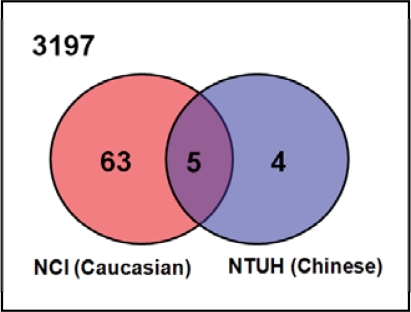
The Venn diagram of significant genes in our and NCI datasets. In order to compare the difference of differentially expressed genes selected in NTUH and NCI datasets, we only focus on the gene probes common in both datasets. After filtering out the genes only present in either NTUH or NCI datasets, a total number of 3197 genes were left, and were considered as our common candidate gene pool for further identification. In the NCI dataset, 68 of the 88 differentially expressed genes (refer to Fig. 1) were in the pool; while NTUH dataset has 9 genes left in the pool. The 67 mutually exclusive genes were selected for further SNP analysis.